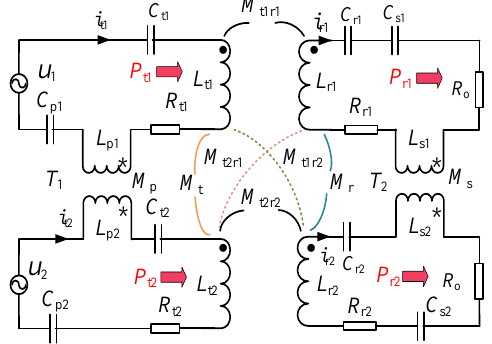
Figure 6. The circuit of proposed WPT system with decoupling transformers.